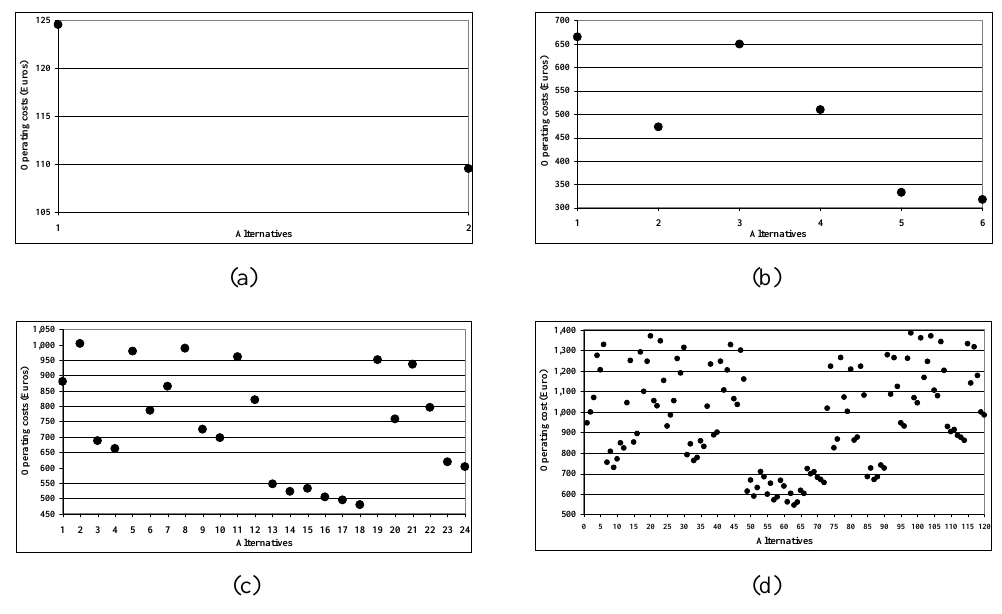
Figure 1. Operating costs for two (a), three (b), four (c) and five (d) aircraft Source: Original figure.